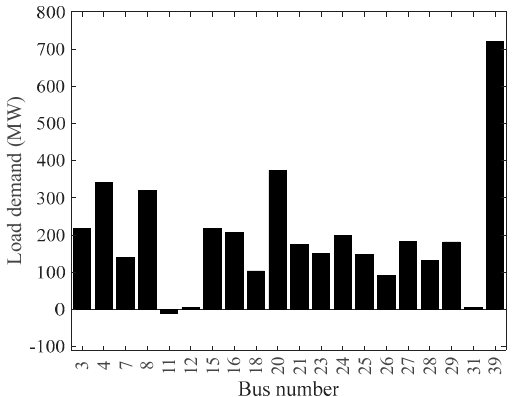
Figure 1. The initial load demands in the transmission system.